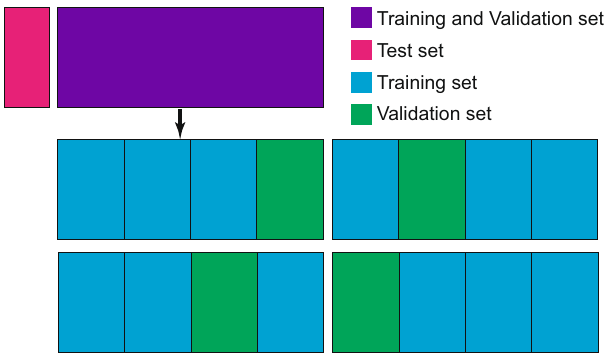
Fig. 8 Data partition during training, validating, and testing. First, the data are split into two sets. The fi rst is the test set. The remaining data set is copied four times and is then split into four sets, each with different parts that act as training sets and validation sets for the training of four deep